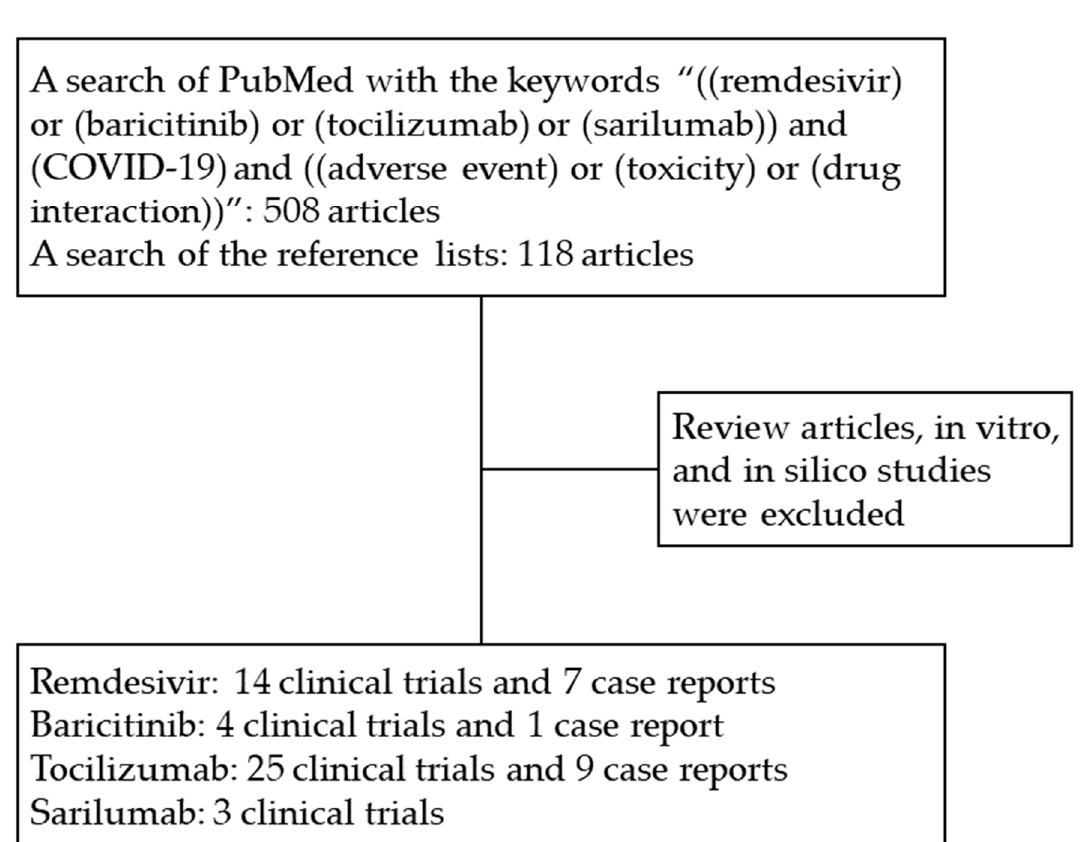
Figure 1. Study flow. Abbreviations: COVID-19, coronavirus disease 2019.